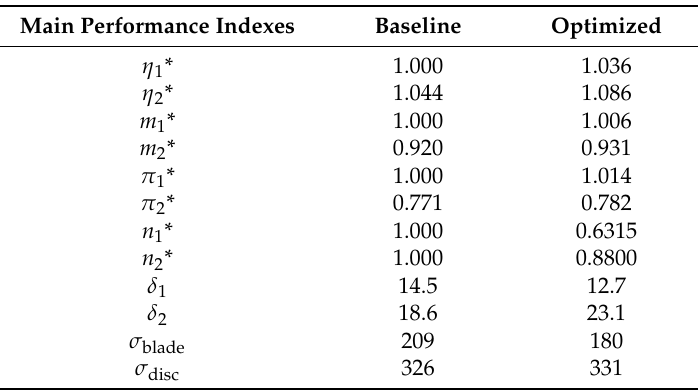
Figure 11. Structure: ( a ) impeller; ( b ) radial diffuser. Table 4. Optimization results for main performance indexes.